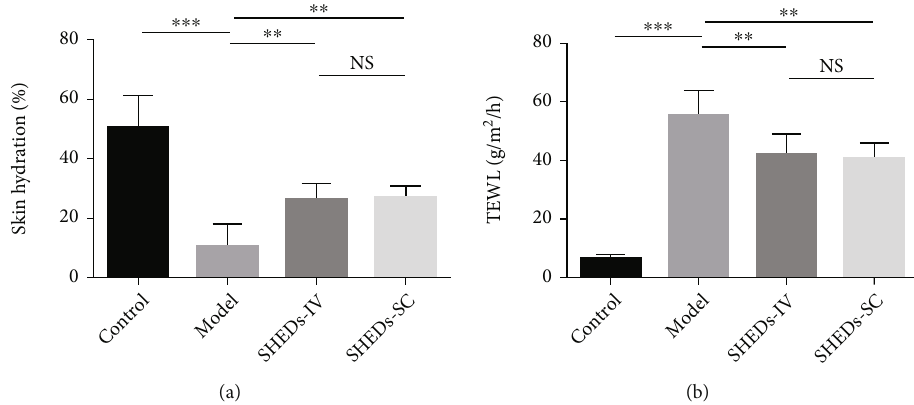
Figure 3: E ff ect of SHEDs on skin barrier. (a) Skin hydration in BALB/c mice of each group. (b) Transepidermal water loss (TEWL) in BALB/c mice of each group. All the data are expressed as mean ± SD ( n = 6 ). Three repeated times of each experiment were